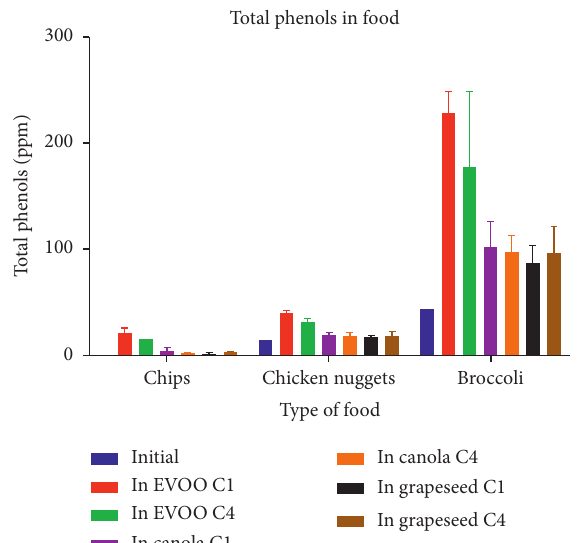
Figure 1: Total phenols in the food (expressed as mg/kg of tyrosol